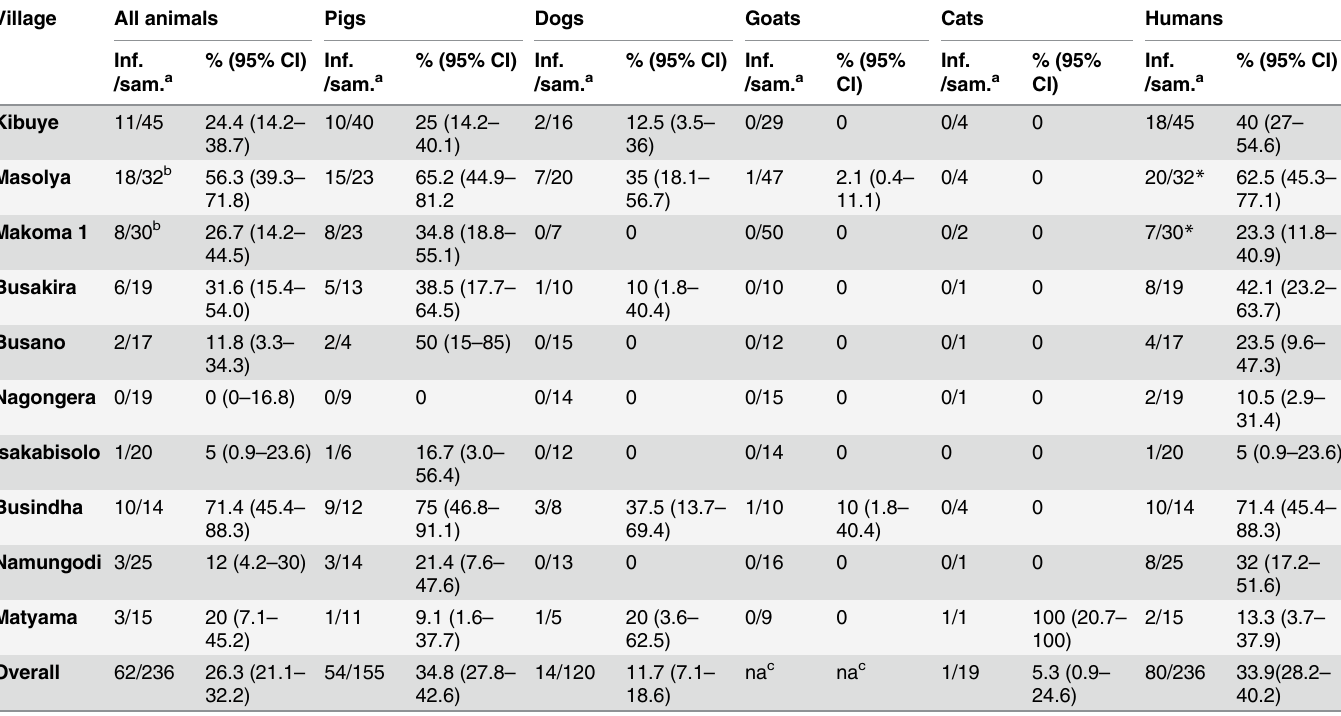
Table 1. Proportions of households with animal tungiasis (at least one animal) according to host species in the 10 villages. Village All animals Pigs Dogs Goats Cats Humans Inf. /sam.